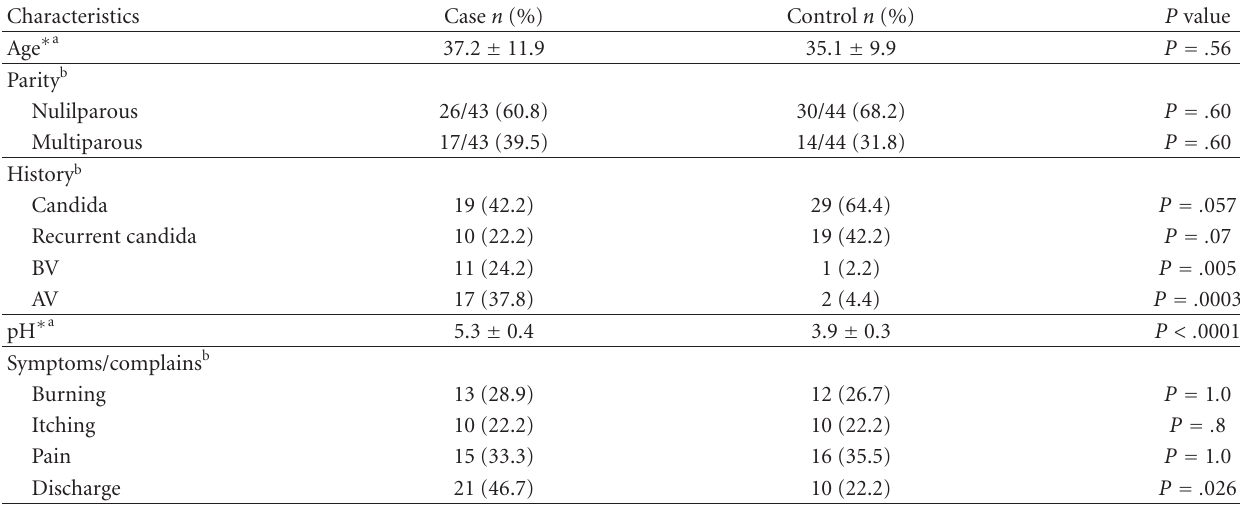
Table 1: Demographic and gynaecological characteristics of the women included in the study, divided into case and control groups, composed by 45 women each.